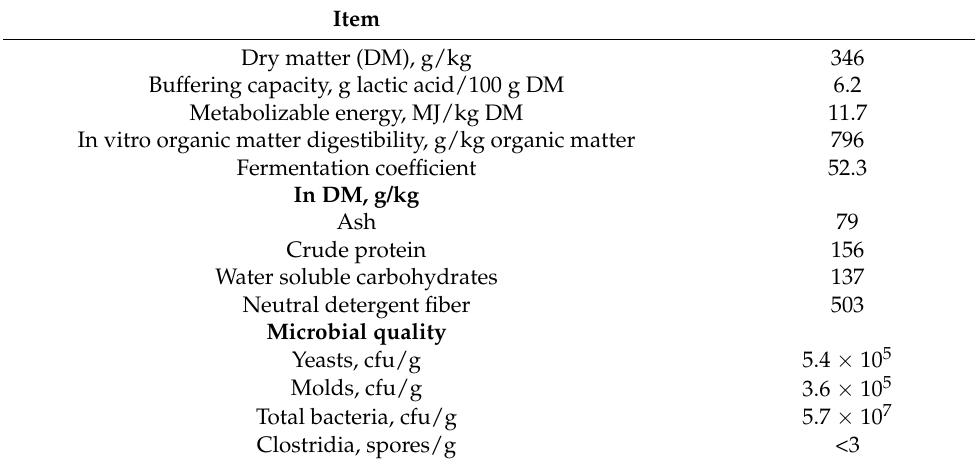
Table 1. Chemical composition and microbial quality of the mixed timothy and meadow fescue grass prior to